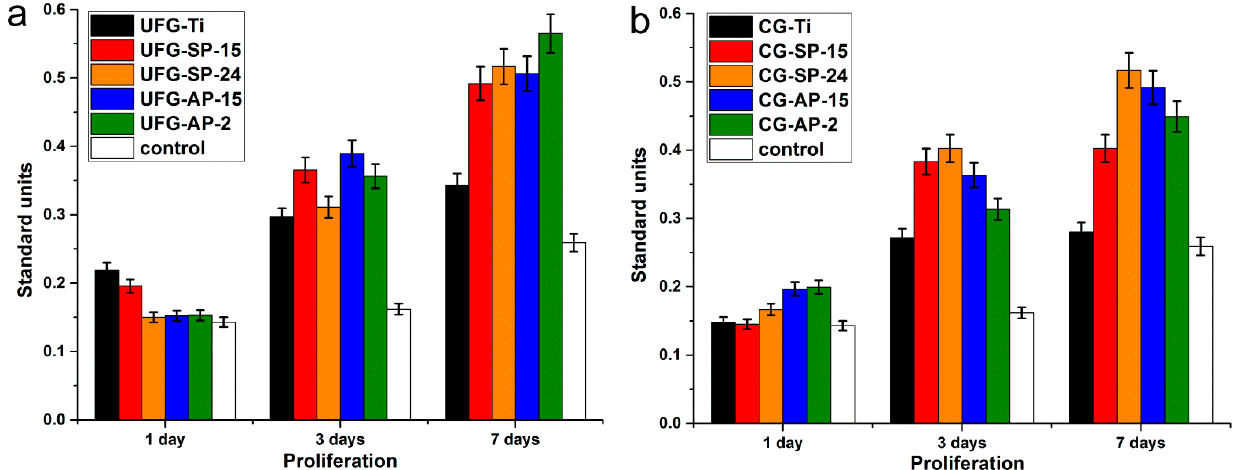
Figure 6. MG ‐ 63 cells proliferation activity after co ‐ incubation on: ( a ) UFG samples; ( b ) CG samples. Data are presented Figure 6. MG-63 cells proliferation activity after co-incubation on: ( a ) UFG samples; ( b ) CG samples. Data are presented as as mean ± S.D. from five independent series of experiments ( p < 0.05). mean ± S.D. from five independent series of experiments ( p <